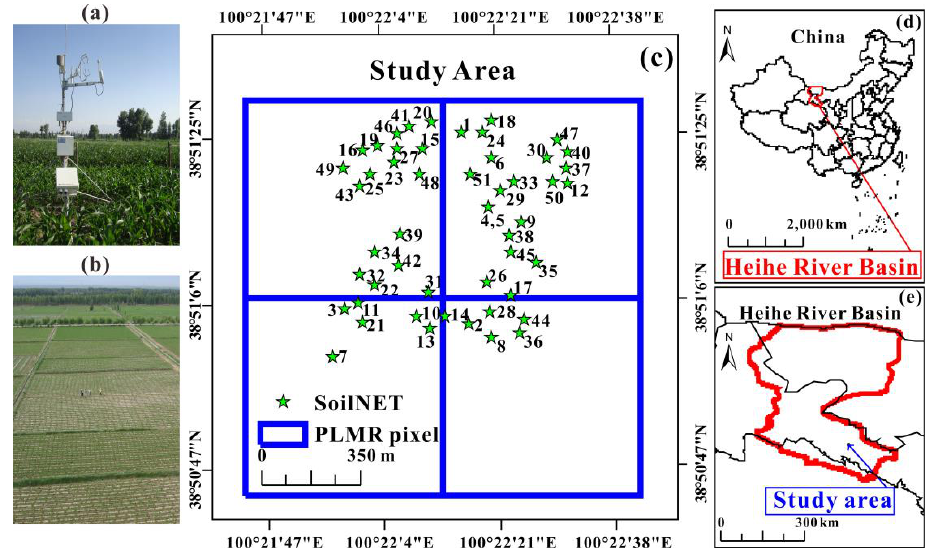
Figure 1. The map of study area with the locations of SoilNET and polarimetric L-band multibeam radiometer (PLMR) products ( c ). The study area is in Heihe River Basin ( e ), in the north of China ( d ). The photos were taken in the Yingke ( a ) and Daman ( b ) irrigation districts and are reprinted from Farmland Ecosystem observation site,